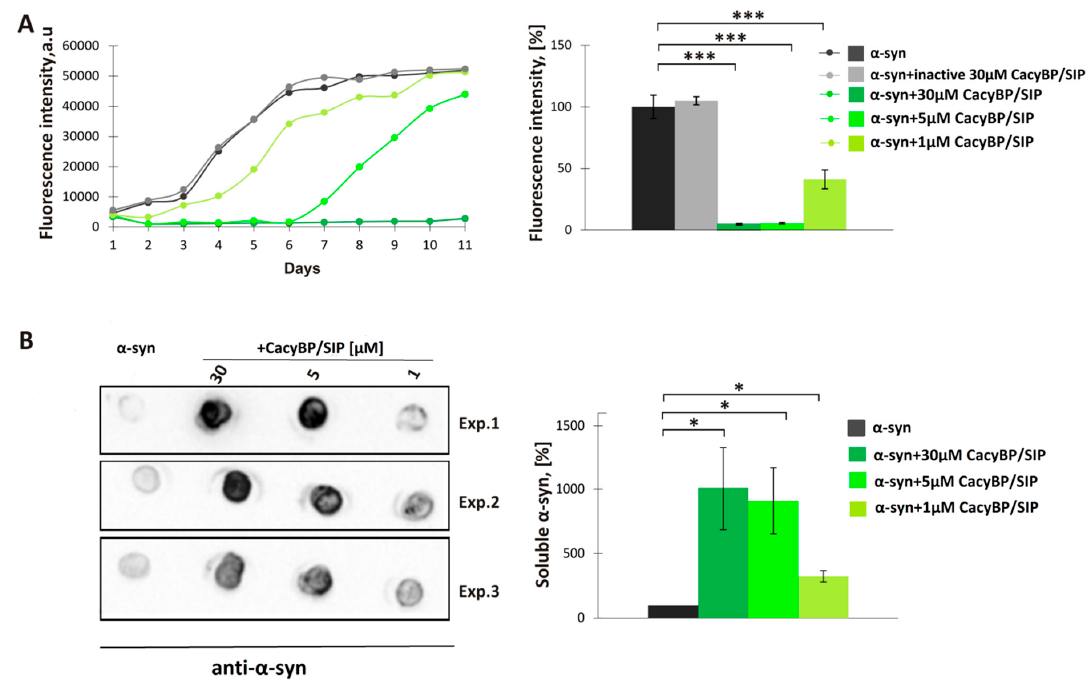
Figure 2. Effect of different concentrations of CacyBP/SIP on α -synuclein aggregation . (A, left panel ) Representative curves showing ThT fluorescence of 30 µM α -synuclein alone (black) or in the presence of: 30 µM inactive CacyBP/SIP (grey) or 30 µM (dark green), 5 µM (middle green) or 1 µM CacyBP/SIP (light green). ( A, right panel ) Statistical analysis of the results for samples taken on day 4 of incubation ( n = 3). ( B, left panel ) Dot-blots showing α -synuclein immunostaining in the soluble fraction (supernatant) of samples taken on day 4 of incubation of α -synuclein alone or in the presence of different concentrations of CacyBP/SIP and ( B, right panel ) densitometric analysis of the results ( n = 3). Data, calculated as means ± SEM, are presented as percentage values. * p ≤ 0.05, *** p ≤ 0.001.